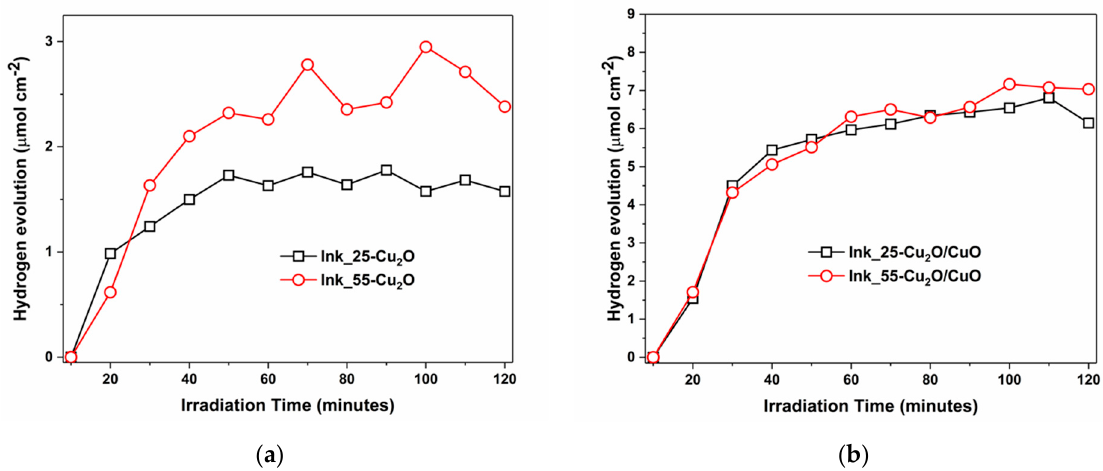
Figure 11. Hydrogen evolution by photoelectrochemical cells with a working electrode based on ( a ) Cu 2 O- and ( b ) Cu 2 O/CuO-based films.